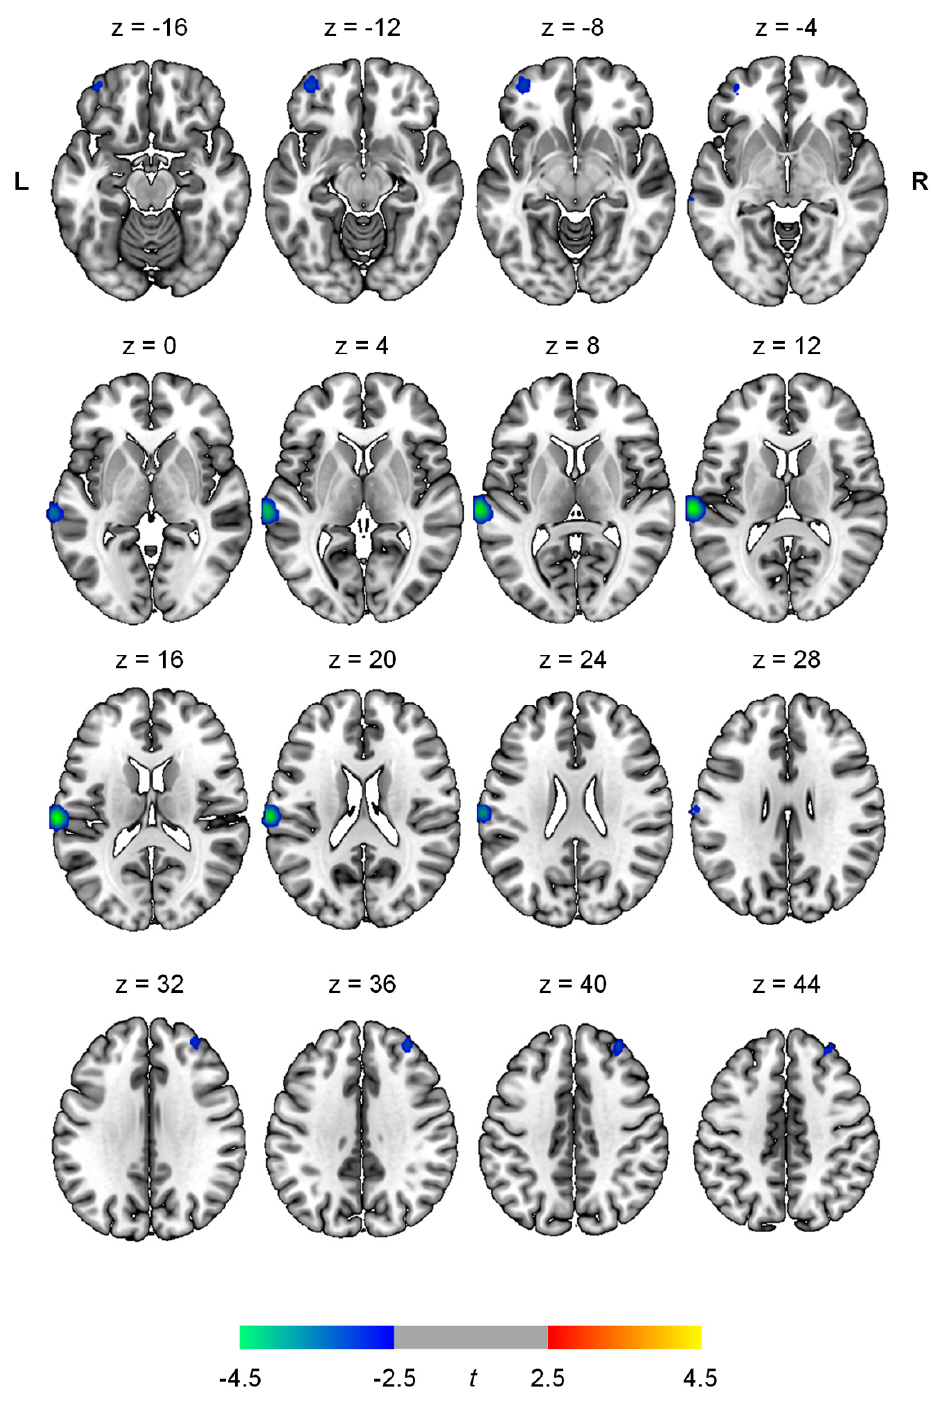
Figure 1. Group differences in relative regional cerebral blood flow (rCBF) between MCI patients with and without dizziness. Decreased rCBF is shown in the left superior temporal gyrus, left lateral orbital gyrus, and right middle frontal gyrus in patients with dizziness compared with patients without dizziness, after adjusting for age and sex ( p < 0.005, extent = 100). The numbers above the brain slices indicate z coordinates in the Montreal Neurological Institute space. The color bar represents the voxel-level t-values.